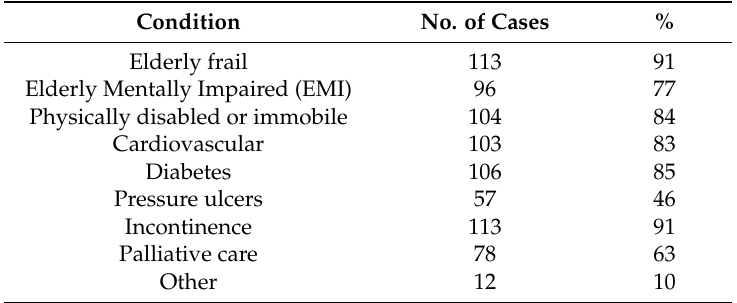
Table 2. Most prevalent conditions reported in residents of care homes of respondents.